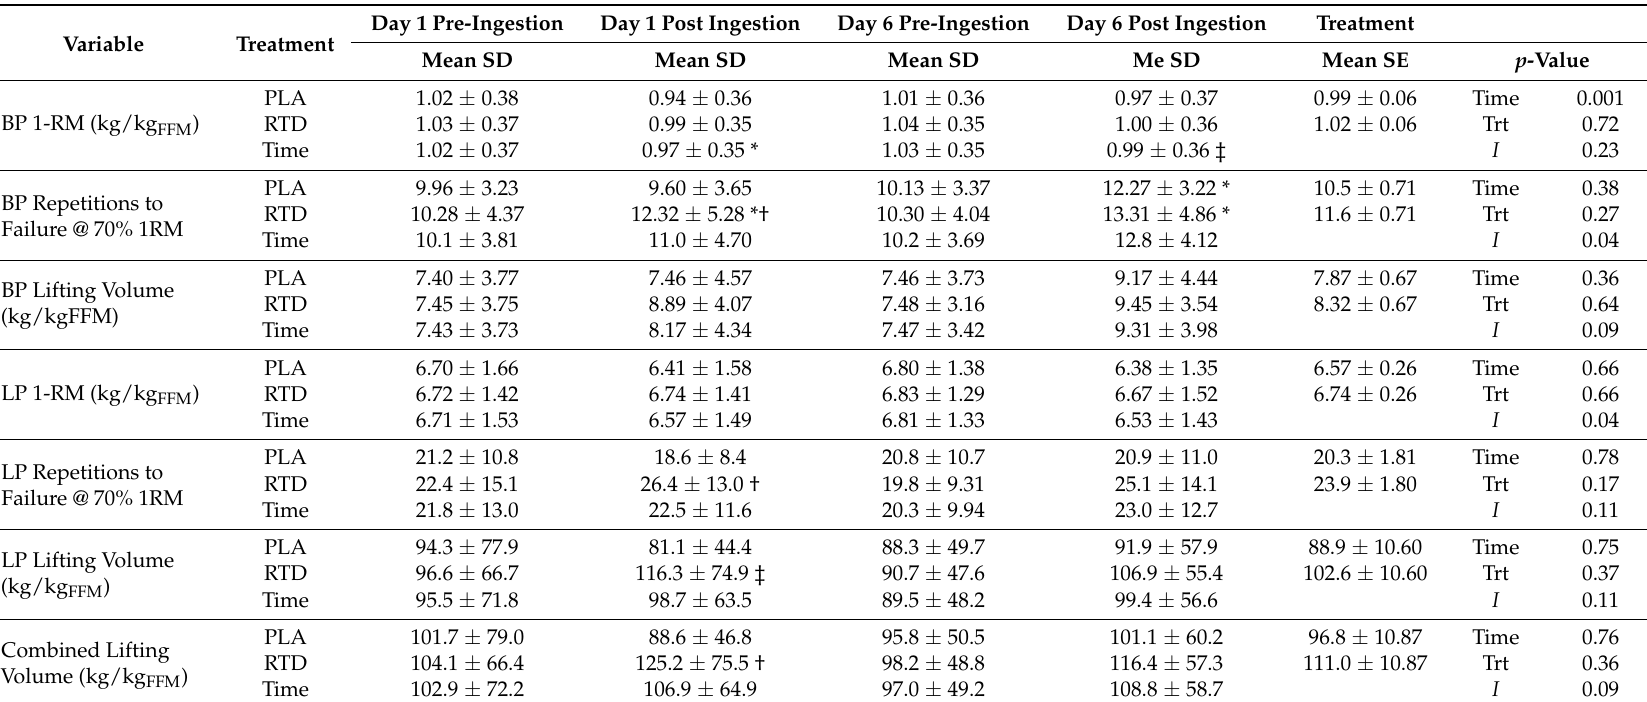
Table 2. Strength and Muscular Endurance Relative to Fat Free